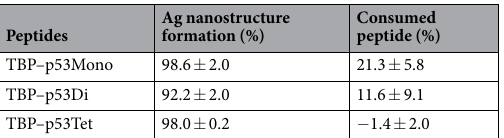
Table 3. The formation rate of silver nanostructure and the percentage of remaining peptide after silver nanostructure formation by using TBP ‒ p53Mono, TBP ‒ p53Di and TBP ‒ p53Tet. Standard errors of mean are